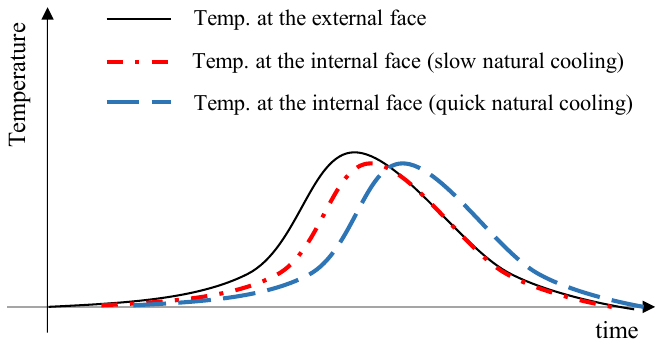
Figure 1. Daily variation of temperature in a ventilated